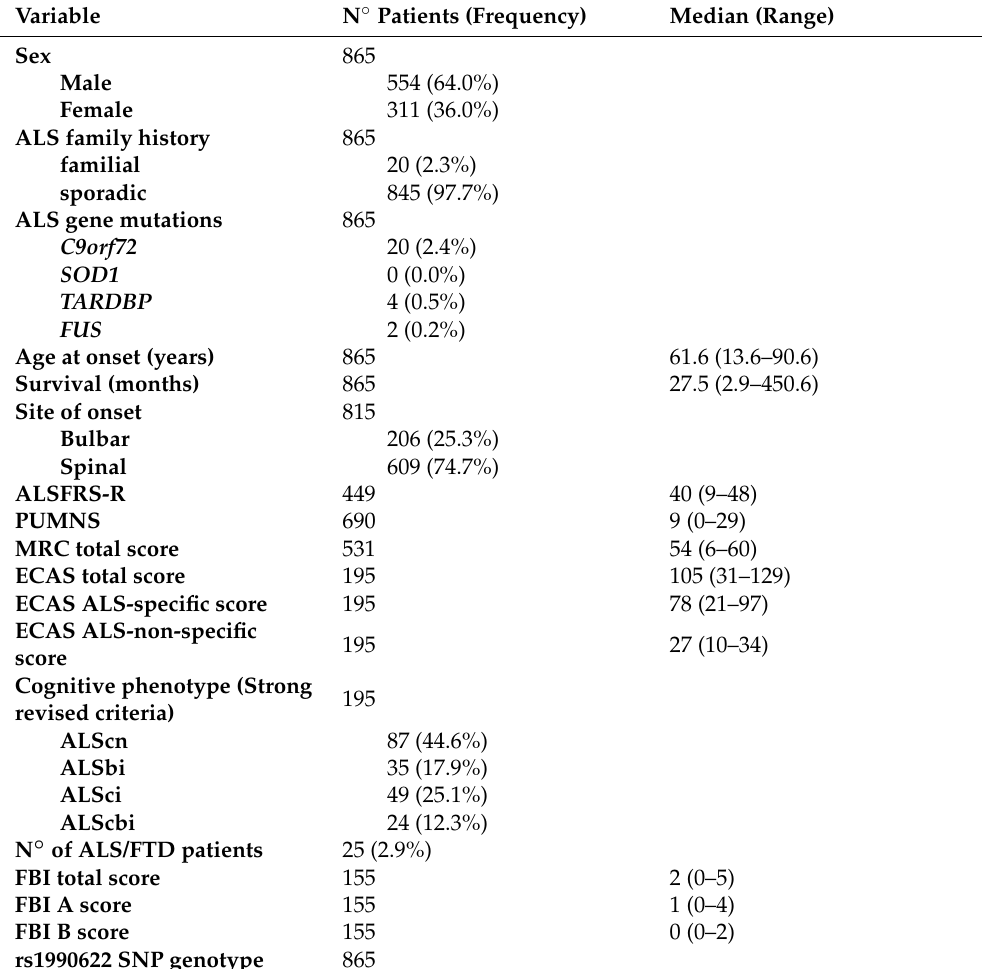
Table 1. Demographic and clinical features, and genotype data of the ALS